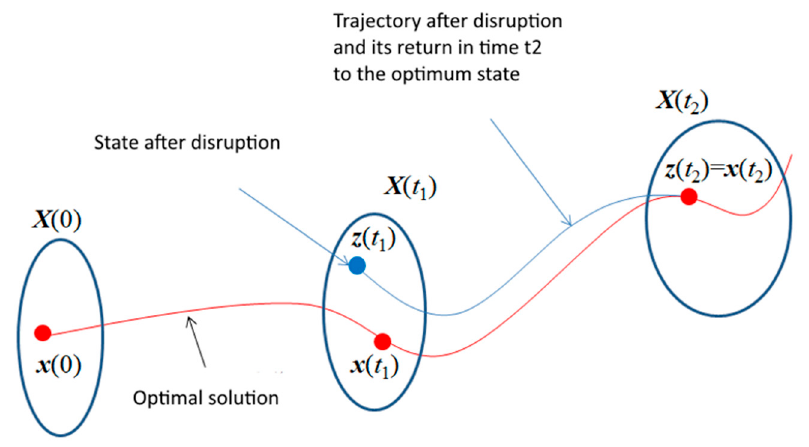
Figure 5. Adaptable systems.